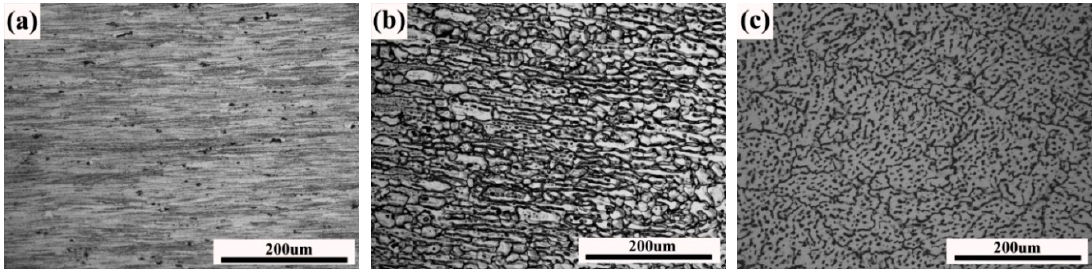
Figure 3. Optical microstructures of the welded joint: ( a ) BM; ( b ) HAZ; and ( c ) WMZ.